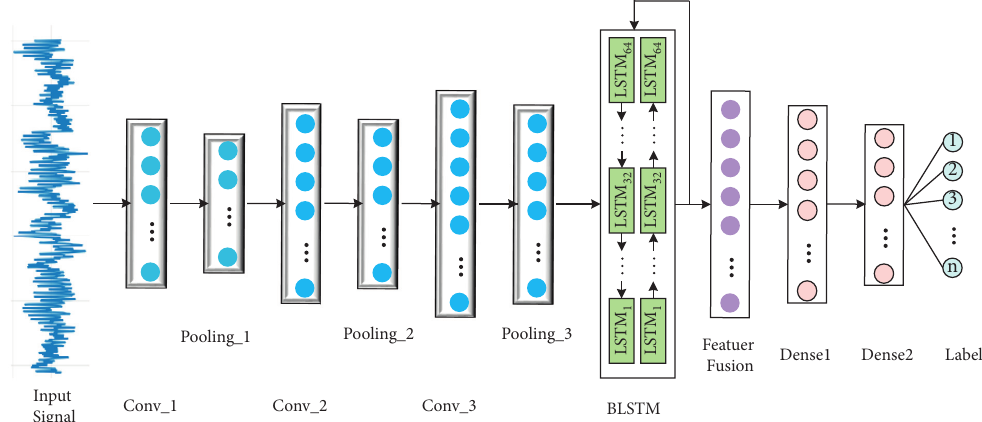
Figure 3: CNN-BLSTM model structure frame diagram.